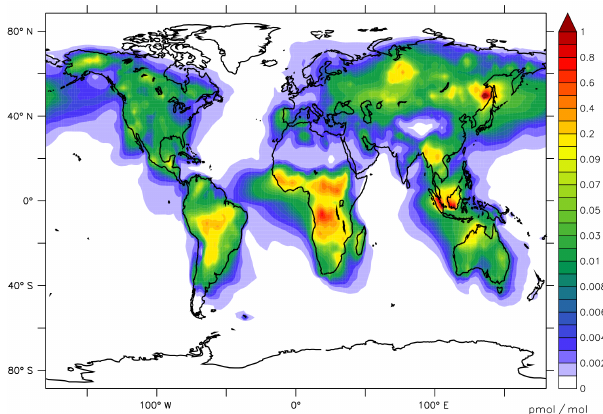
Figure 13. Model-calculated annual near-surface average of carbon suboxide mixing ratios in pmolmol − 1 .